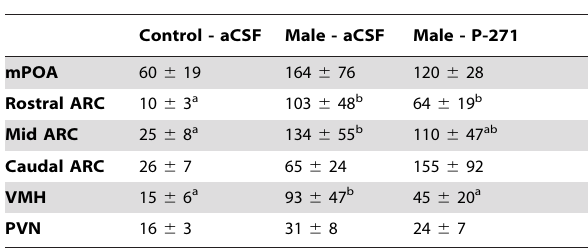
Table 1. Number of Fos-ir cells in anestrous ewes exposed to males and treated with a kisspeptin antagonist (P-271) or vehicle (aCSF).